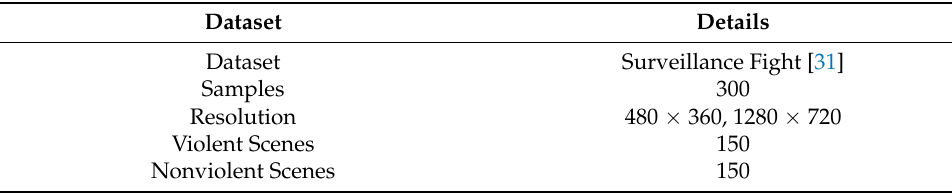
Table 6. Description and statistics of the Surveillance Fight